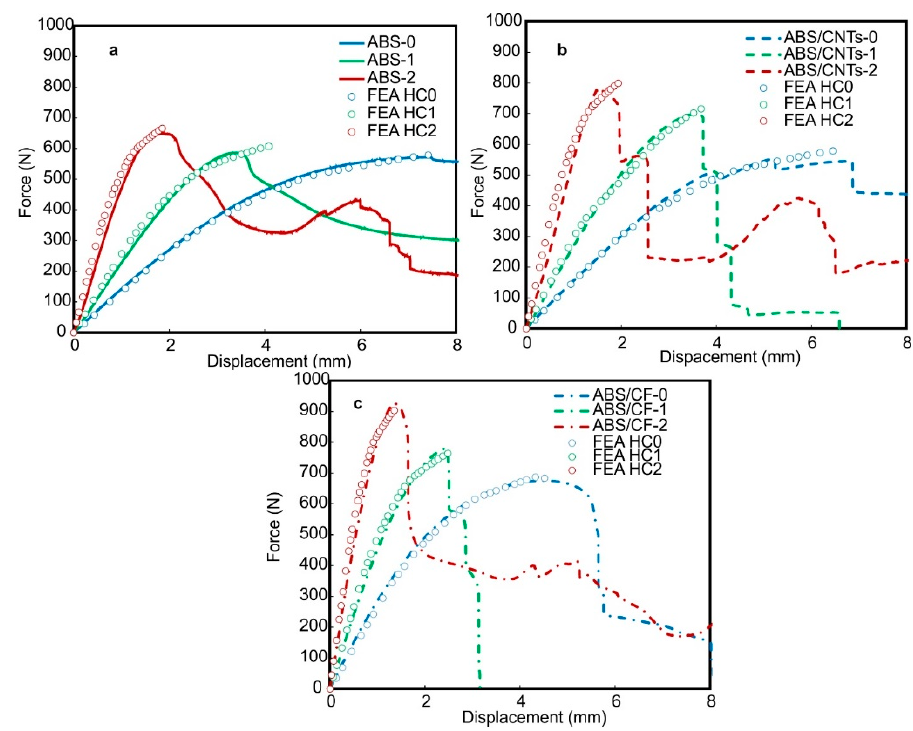
Figure 7. Typical experimental load displacement curves and the curve-fit utilizing an FE model of HC0, HC1 and HC2 structures for ( a ) ABS, ( b ) ABS/CNT and ( c ) ABS/CF materials.